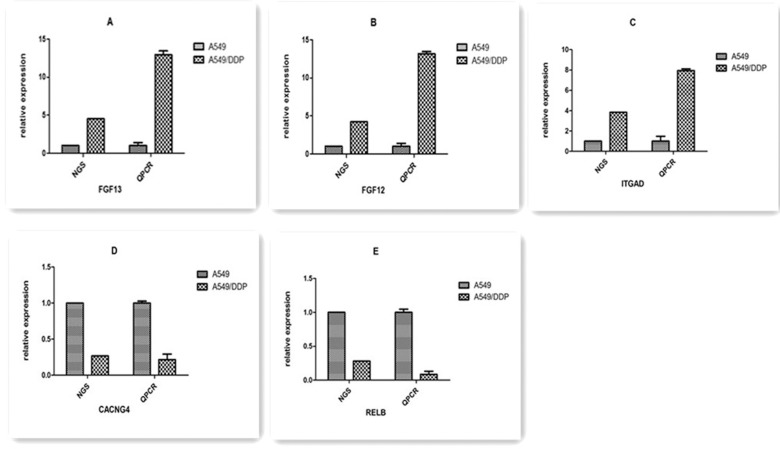
The differentially expressed genes detected by transcriptome sequencing confirmed by qRT-PCR.qRT-PCR was performed for 5 genes that were identified to be differentially expressed between A549 and A549/DDP cells. The expression level of each gene was normalized to the level in A549 cells. A–E: FGF13, FGF12, ITGAD, CACNG4, and RELB, respectively.